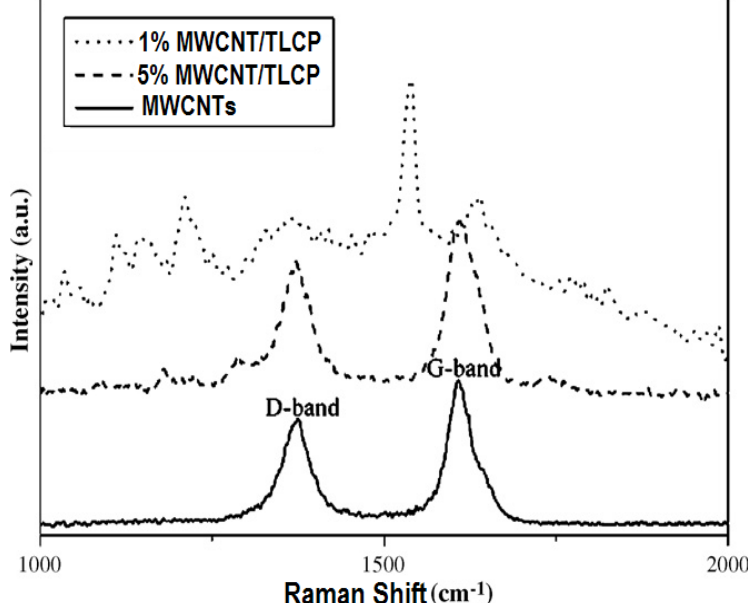
Figure 3. Raman spectra of MWCNTs and MWCNT/TLCP nanocomposites. Reprinted with permission from Reference [58]. Copyright 2010, Elsevier Science Ltd.,